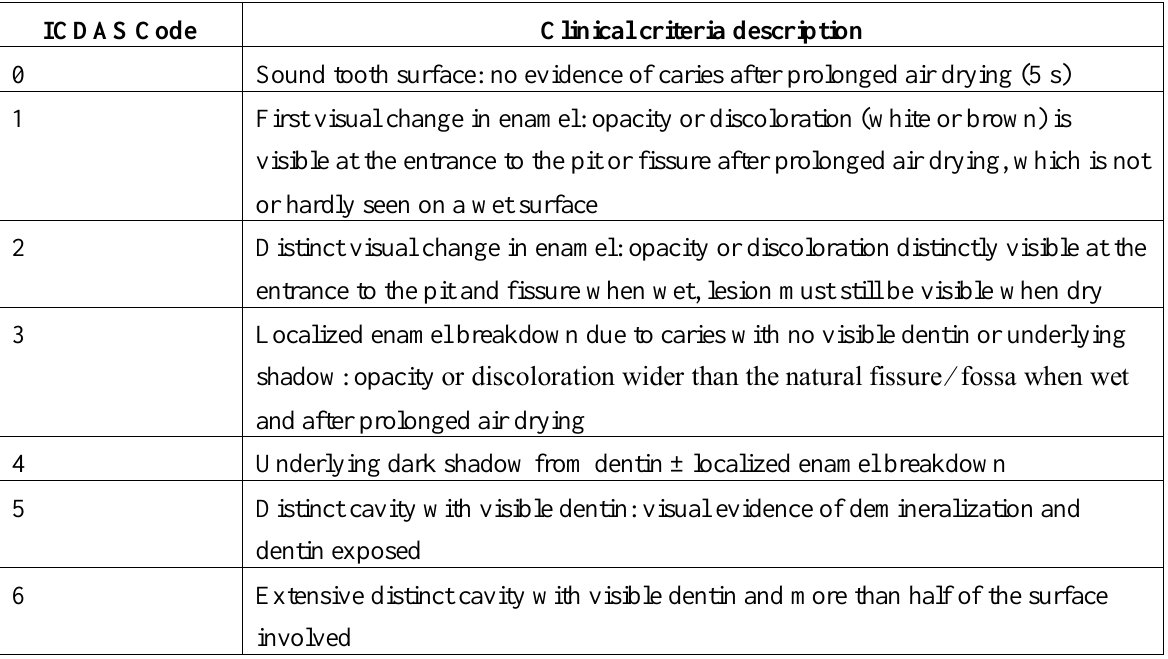
Table 1. International Caries Detection and Assessment System (ICDAS)